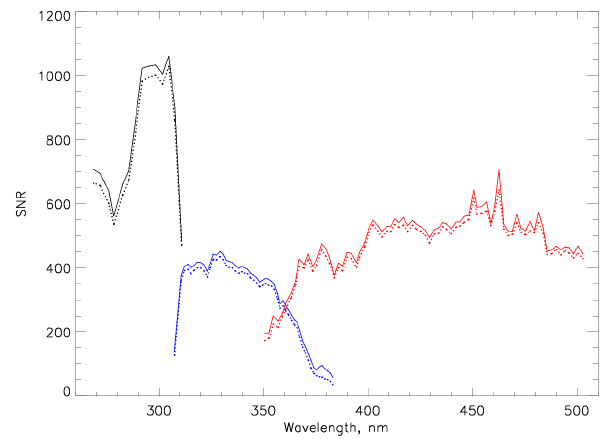
Figure 15. Random telegraph signal (RTS) flagging trend over the mission. These results are for unbinned pixels. The binned L1B pix- els have flagging rates that are 8 times higher.